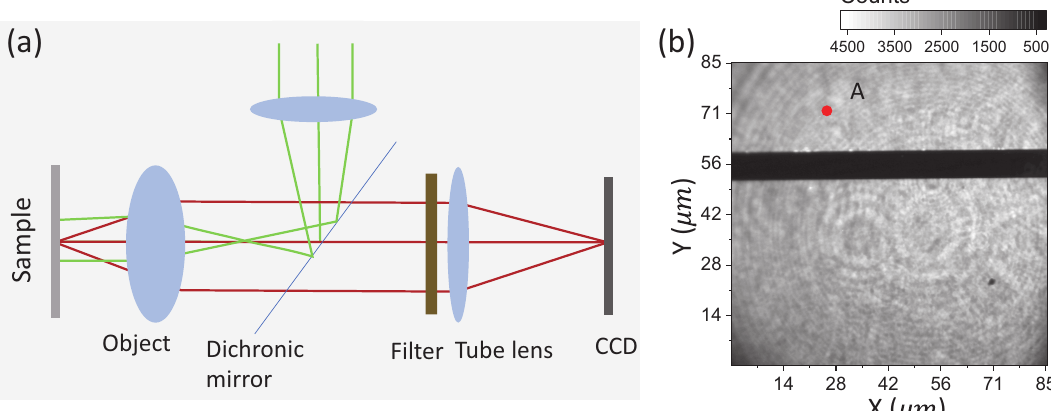
Figure 5. ( a ) Schematic diagram of wide-field fluorescence microscopy. The green light was focused at the back focal are of the object to excite NV centers with collimated light. The red fluorescence emitted by the NV centers was collected by the same object. The dichroic mirror was used to separate the laser and fluorescence. At last, the fluorescence was further filtered and focused on the EMCCD. ( b ) Wide-field fluorescence imaging of the diamond sample without the MW field fed in. The dark strip indicates the position of the metal MW strip